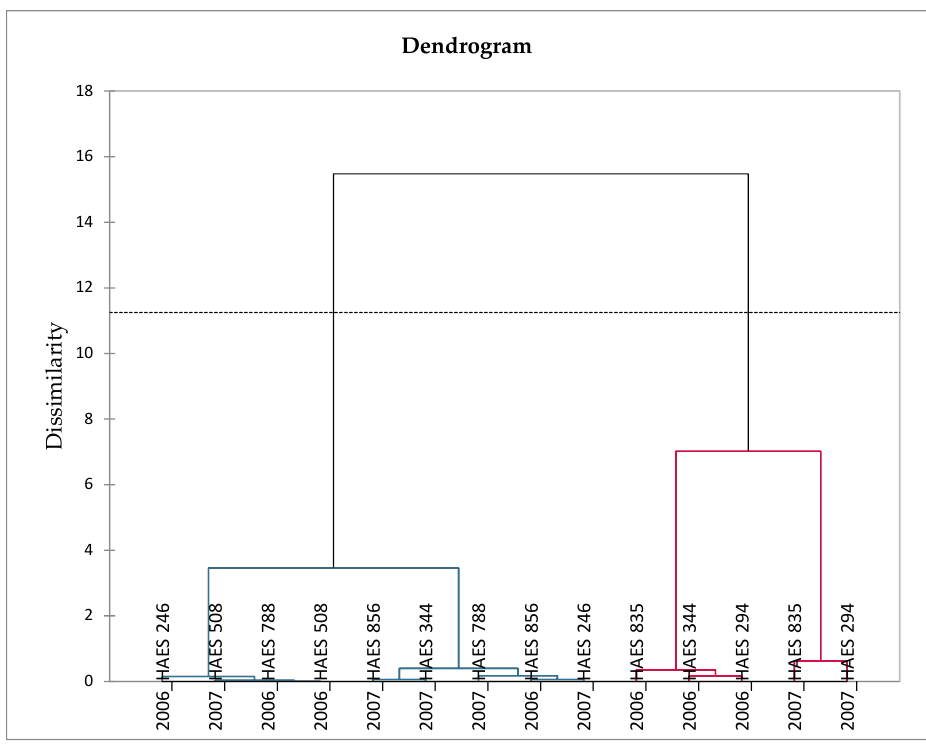
Figure 7. Agglomerative hierarchical clustering showing the variation of oxidative stability and antioxidant properties of cold-pressed macadamia nut oil with cultivar (from Hawaii) and season. HAES: Hawaii Agricultural Experiment Station. Adapted from Wall et al. [14].